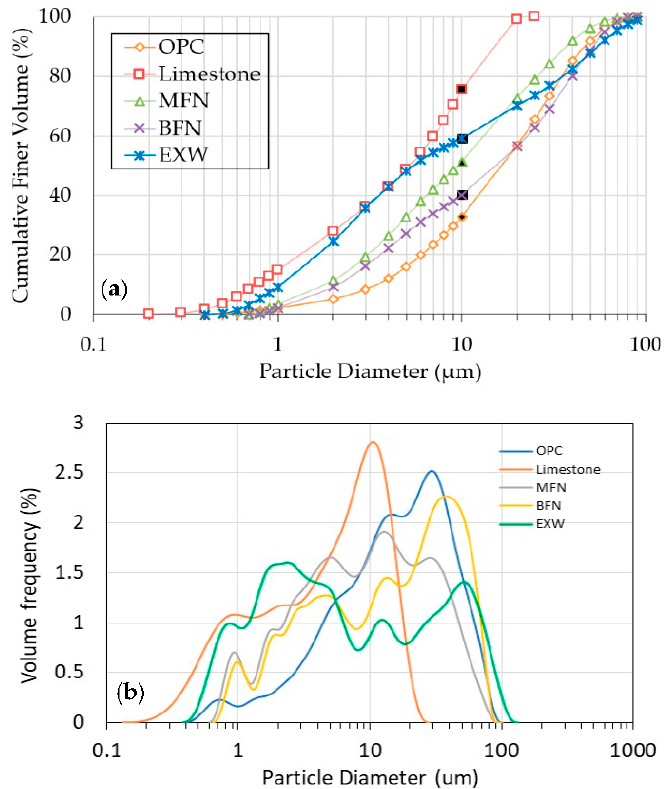
Figure 3. Particle size distribution of the binders: ( a ) cumulative finer volume, ( b ) percentage distribution of the sizes.